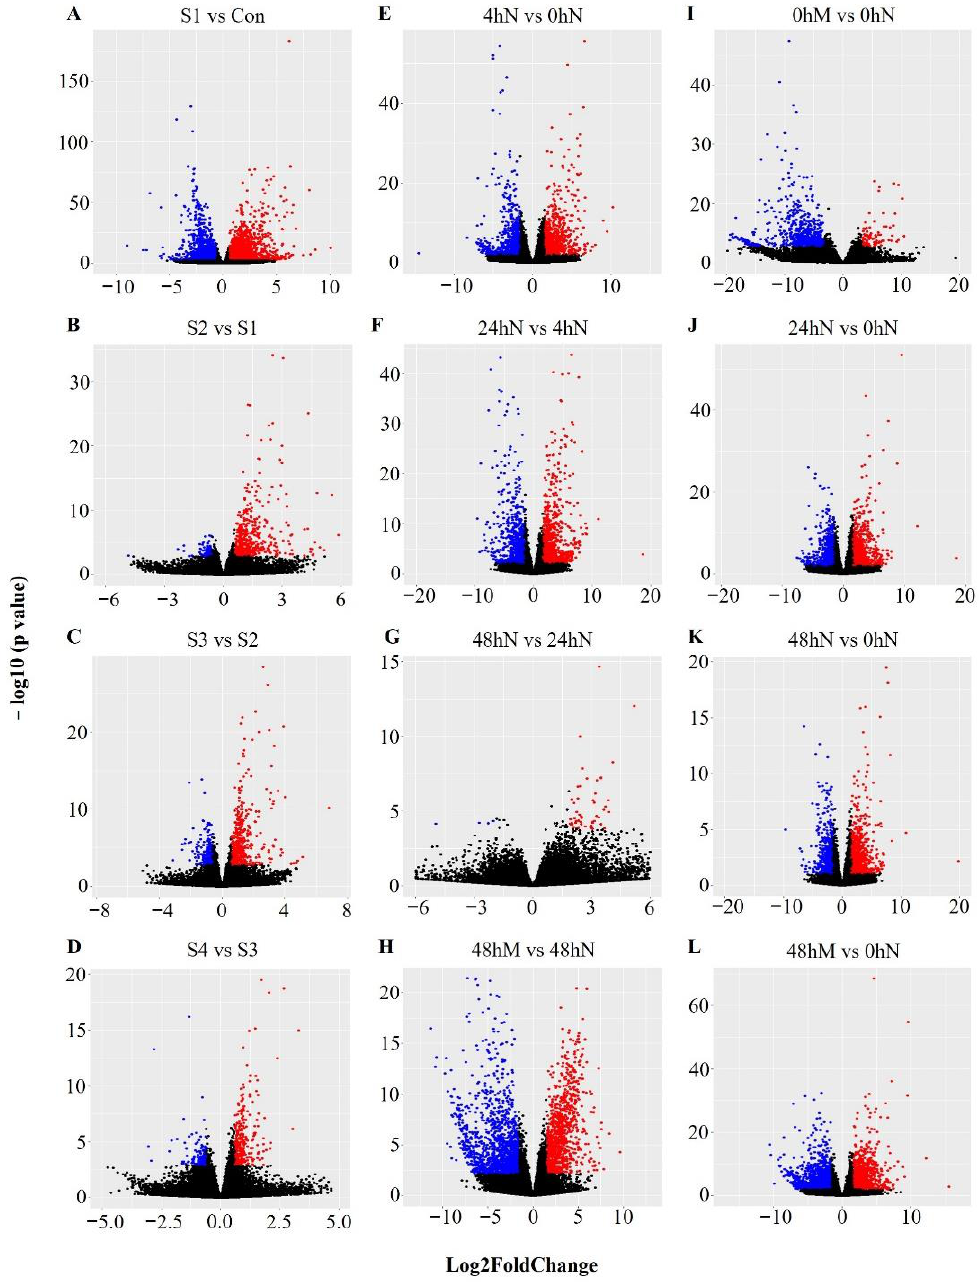
Figure 5. Volcano plots showing statistical significance of changes in gene expression and their expression fold-change during plantlet formation. Each plot shows a comparison between two developmental stages of plantlet formation in K. daigremontiana ( A – D ) or between two time points post-detachment of K. pinnata leaves ( E – L ). Each plot shows − log10 ( p -value) against log2 fold-change. Blue: False discovery rate (FDR) ≤ 0.05, log2 fold-change ≤ − 0.6 for ( A – D ), log2 fold-change ≤ − 1.585 for ( E – L ); Red: FDR ≤ 0.05, log2 fold-change > 0.6 for A–D, log2 fold-change > 1.585 for ( E – L ); Black: Not significant. Con: Control; S1: Stage 1; S2: Stage 2; S3: Stage 3; S4: Stage 4; N: Leaf notches; M: Leaf